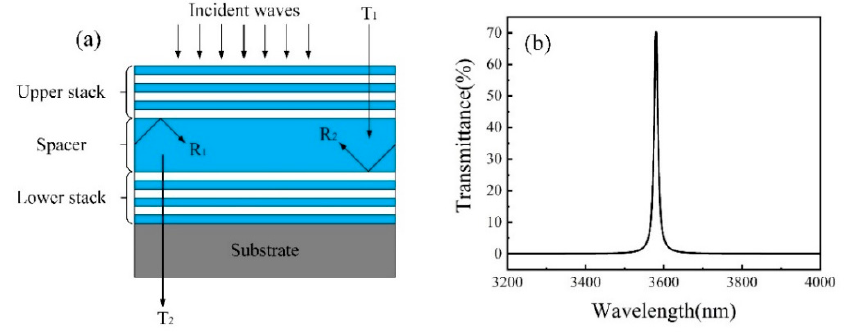
Figure 2. ( a ) Schematic diagram of an all-dielectric F-P type filter and ( b ) its typical transmittance spectrum.